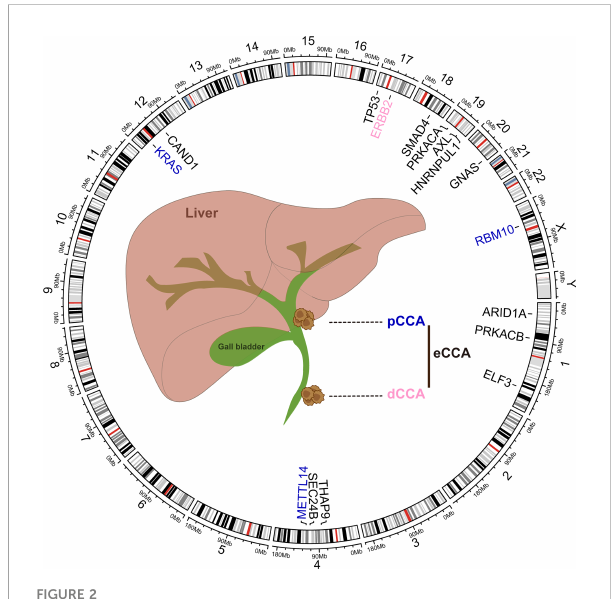
FIGURE 2 Common genomic alterations in extrahepatic cholangiocarcinoma. The genetic alterations and locations in human chromosomes (hg38) were depicted in the circos plot executed by R language package